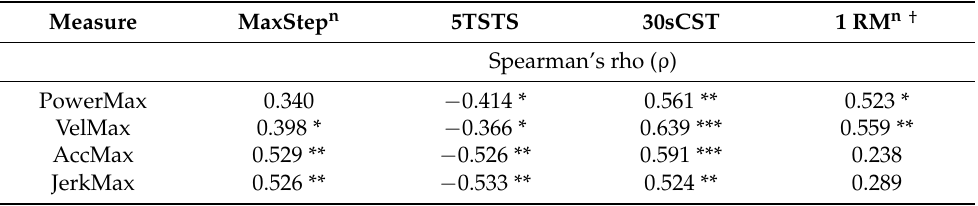
Table 8. Correlation result between clinical leg strength instruments and the sensor-test for Three Maximal Chair Stand Test (n = 31), using Spearman’s rho ( ρ